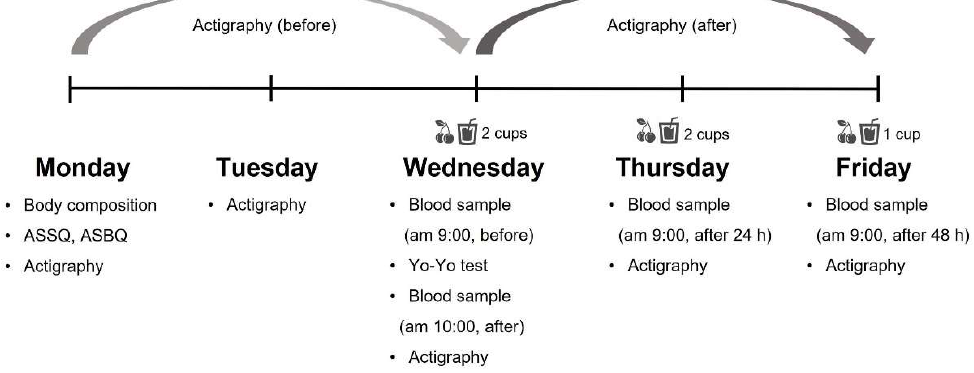
Figure 2. A brief design of the study.